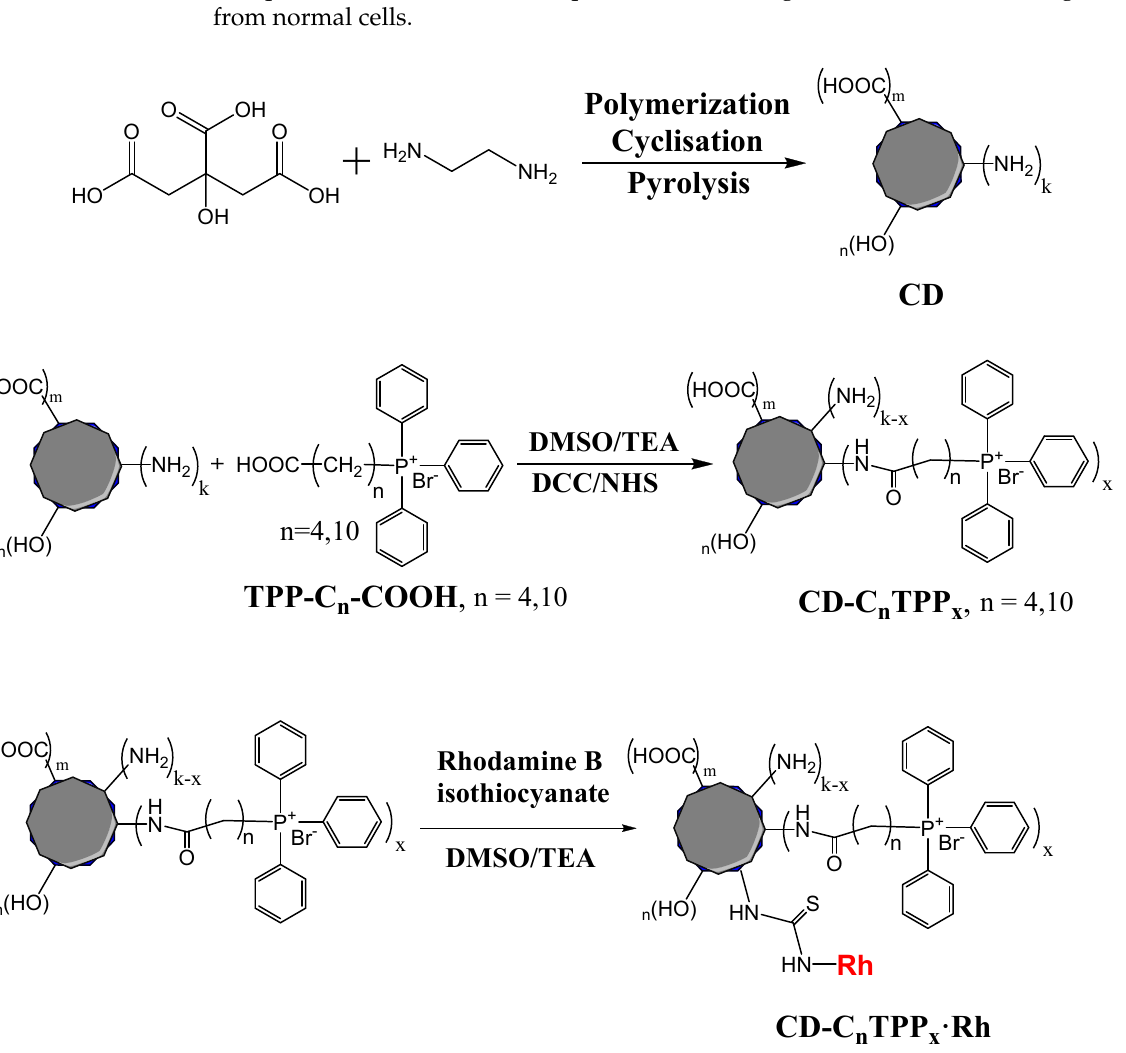
Scheme 1. Microwave synthesis of N-doped carbon dots and their subsequent functionalization with alkyl-TPP groups and rhodamine B isothiocyanate.